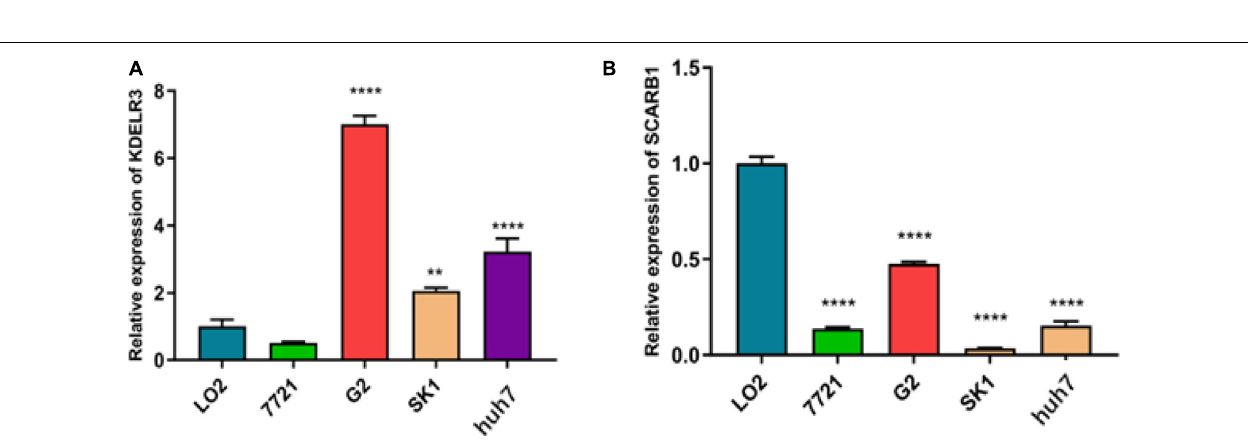
Frontiers in Genetics |